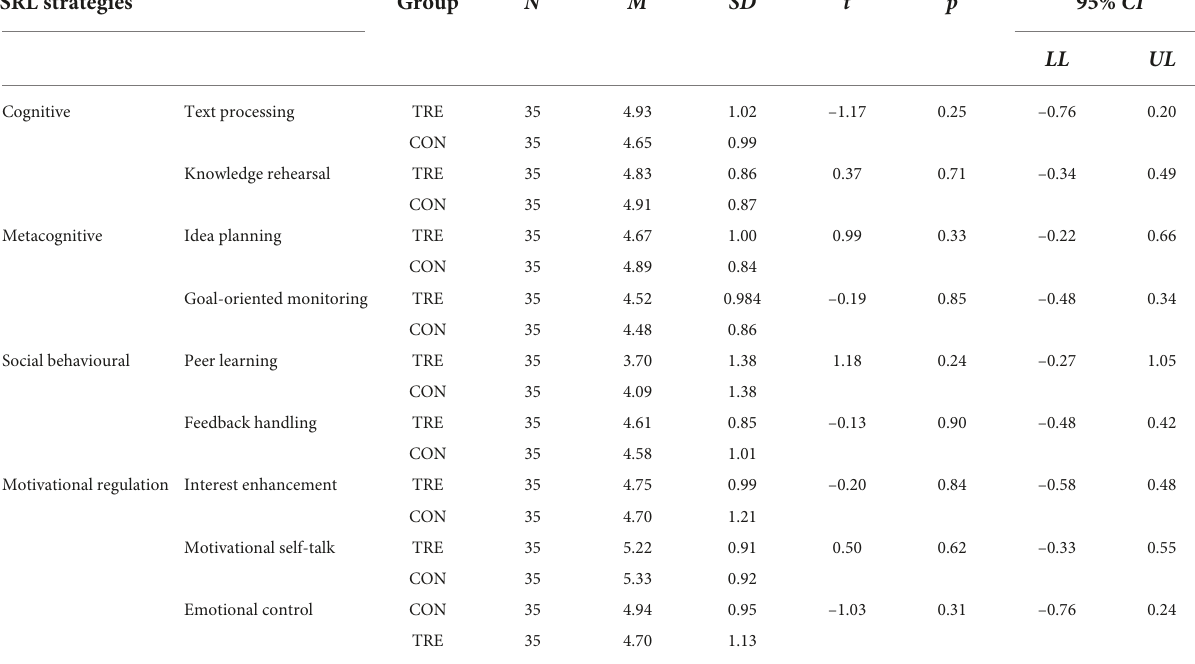
TABLE 5 Descriptive statistics and independent samples t -tests of self-regulated learning (SRL) strategies scores for the control and treatment groups in the pre-test. SRL strategies